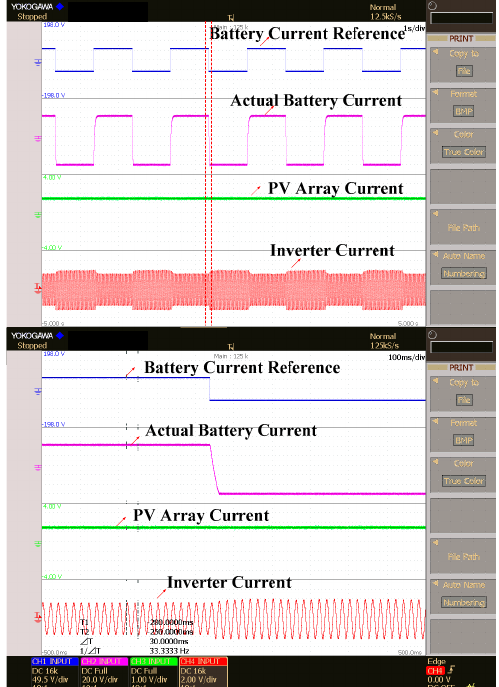
Figure 9. Change in the battery, PV array and actual inverter currents with a change in reference battery current at constant irradiance of 1000 watt per square meter in a bi-directional chopper-based ESS in grid-connected mode.